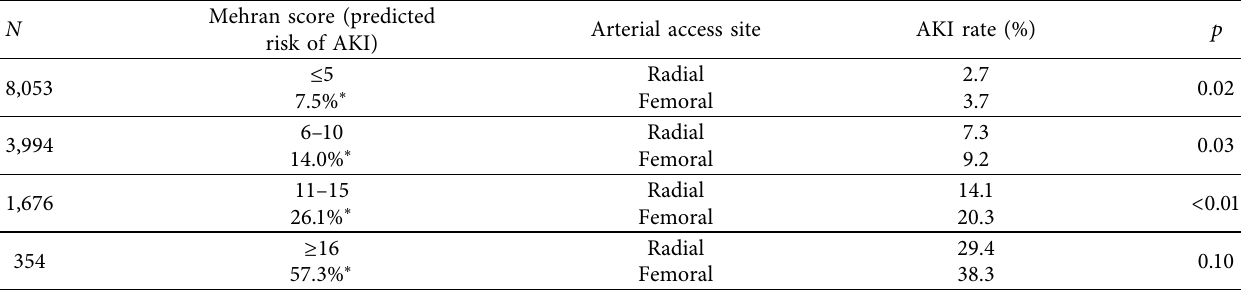
Table 2: AKI by the access site and Mehran risk group.